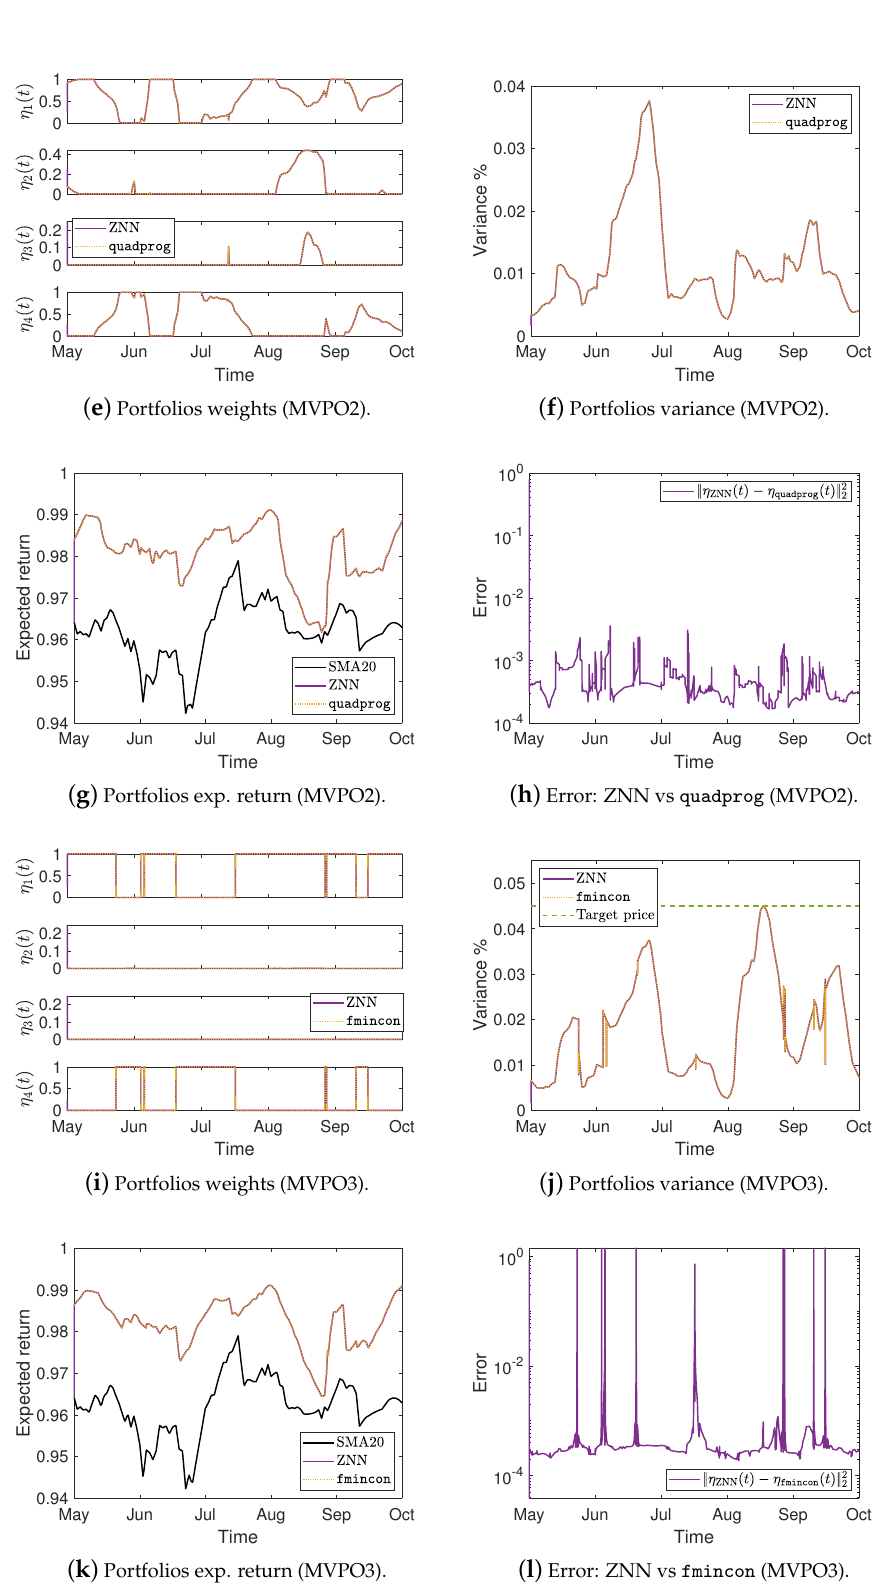
Figure 2. Portfolios weights, variance %, expected return, and the error between ZNN and MATLAB’s solvers in case